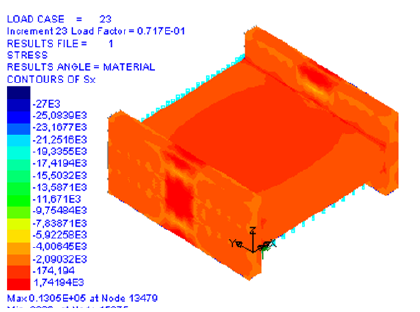
Figure 27: Stress contour in control model (c) configuration Figure 28: Stress contour in strengthened model (c)